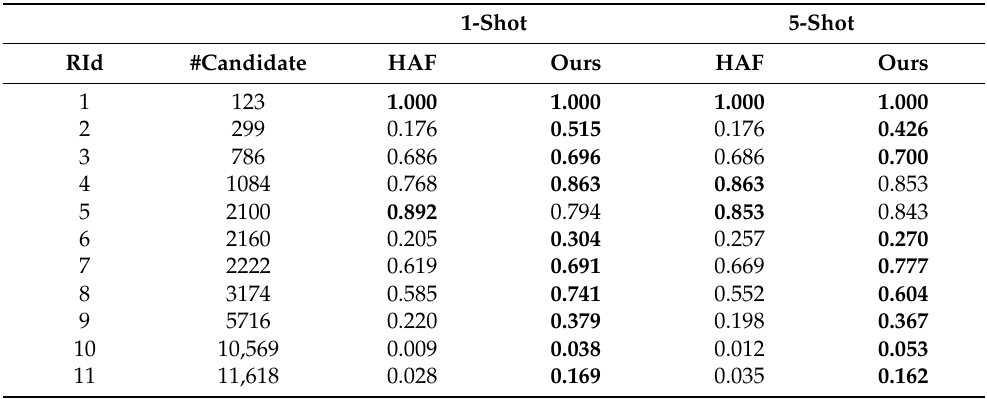
Table 4. Performance representation of different relationships in the test dataset. Bold numbers denote the best results of the